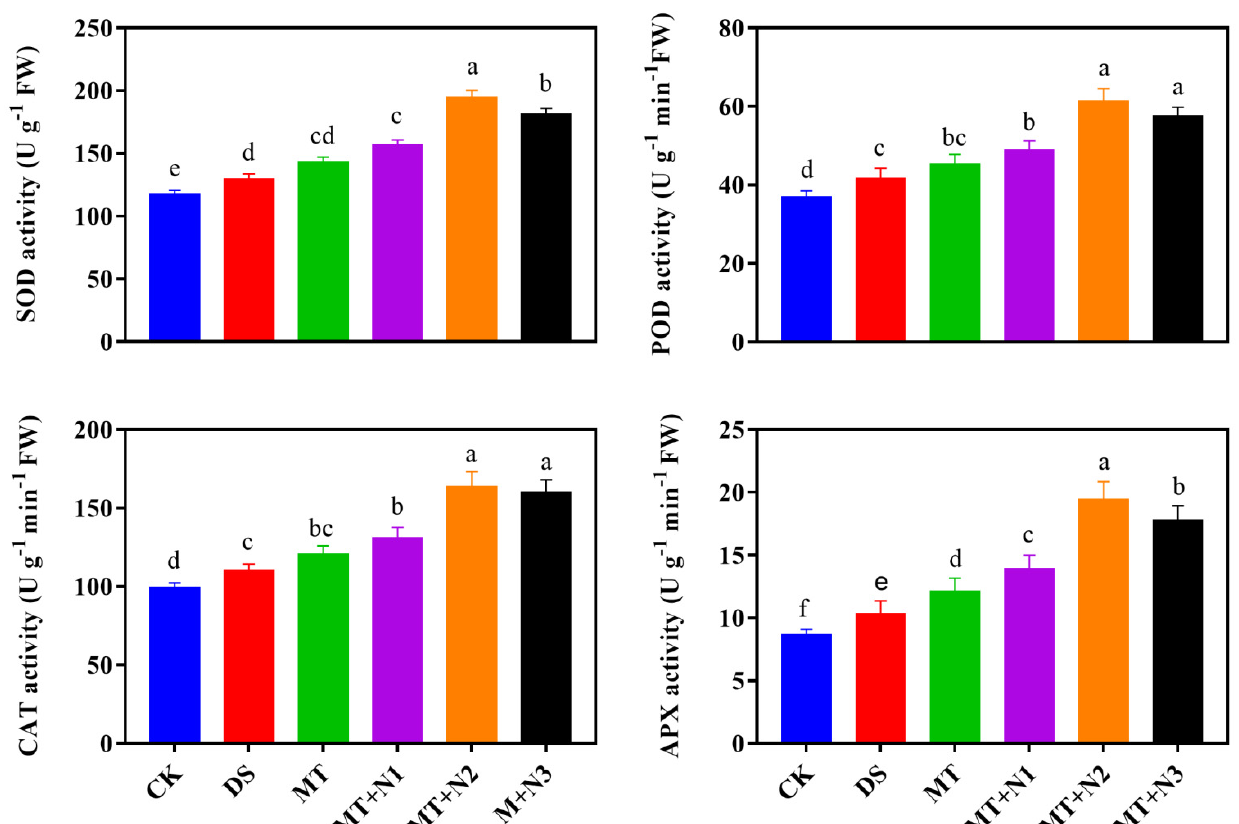
Figure 5. Antioxidant enzyme activities of maize seedlings under drought-stress conditions in combination with melatonin in different levels of nitrogen. CK; Well-watered control without (melatonin) MT, DS; Drought stress without MT, MT; Drought stress + 100 µM MT, MT + N1; MT 100 µM + 200 kg N ha − 1 , MT + N2; MT-100 µM + 250 kg N ha − 1 , and MT + N3; MT-100 µM + 300 kg N ha − 1 . Vertical bars represent ± S.D. ( n = 3, biological replicates). Different letters indicate significant differences as determined by the LSD test ( p ≤ 0.05).